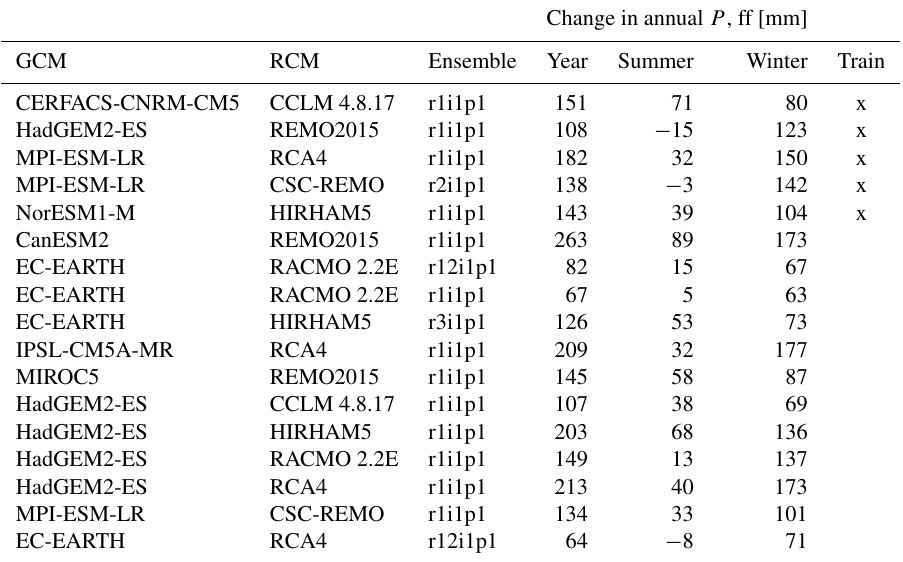
Table 1. Overview over the 17 used bias-corrected RCMs. The training models are marked. Changes to projected precipitation ( P ) are given for the far future (ff) relative to the reference period, yearly as well as separately for the summer and winter half